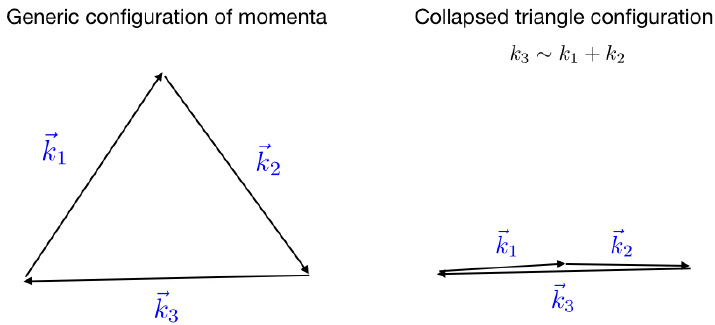
Figure 6. Generic con(cid:12)guration of momenta for a three-point function vs. the collinear con(cid:12)gu- ration (collapsed triangle) k 3 (cid:24) k 1 + k 2 , where the length of one side is the sum of the other two. Note that if the (cid:12)eld (cid:30) ( (cid:23) 1 ) is exactly massless, (cid:23)